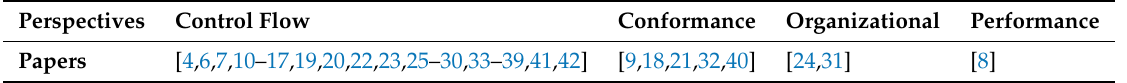
Table 3. Papers with their corresponding process mining perspectives.